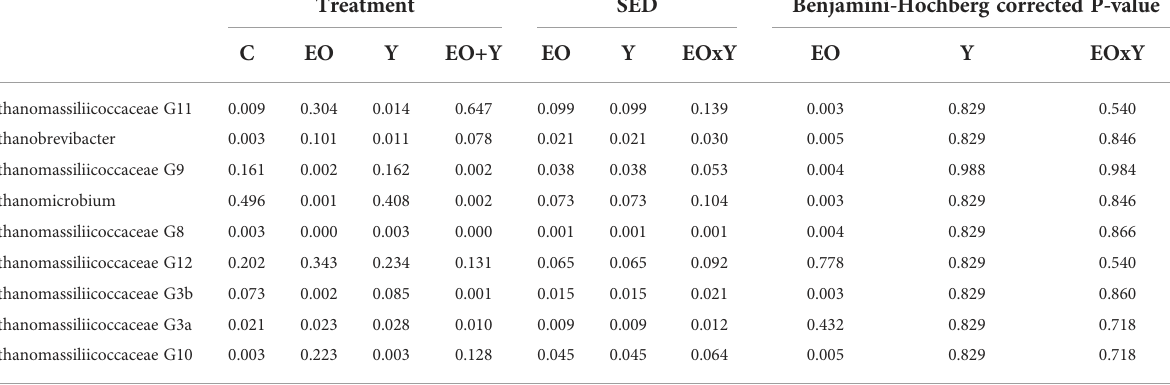
TABLE 8 Effect of supplementing a control diet (C) with oregano oil (EO), yeast (Y) or a combination of both (EO+Y) on the relative abundance of archaeal genera present at an average of more than 0.2% (false discovery rate for Benjamini-Hochberg:0.25). Treatment